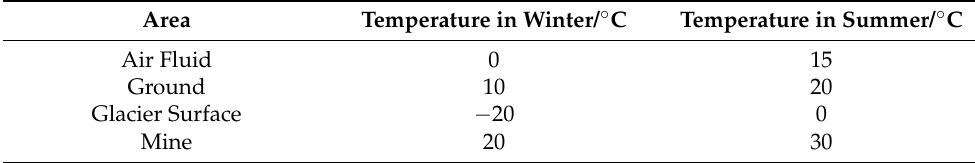
Table 2. Temperature settings in winter and summer.